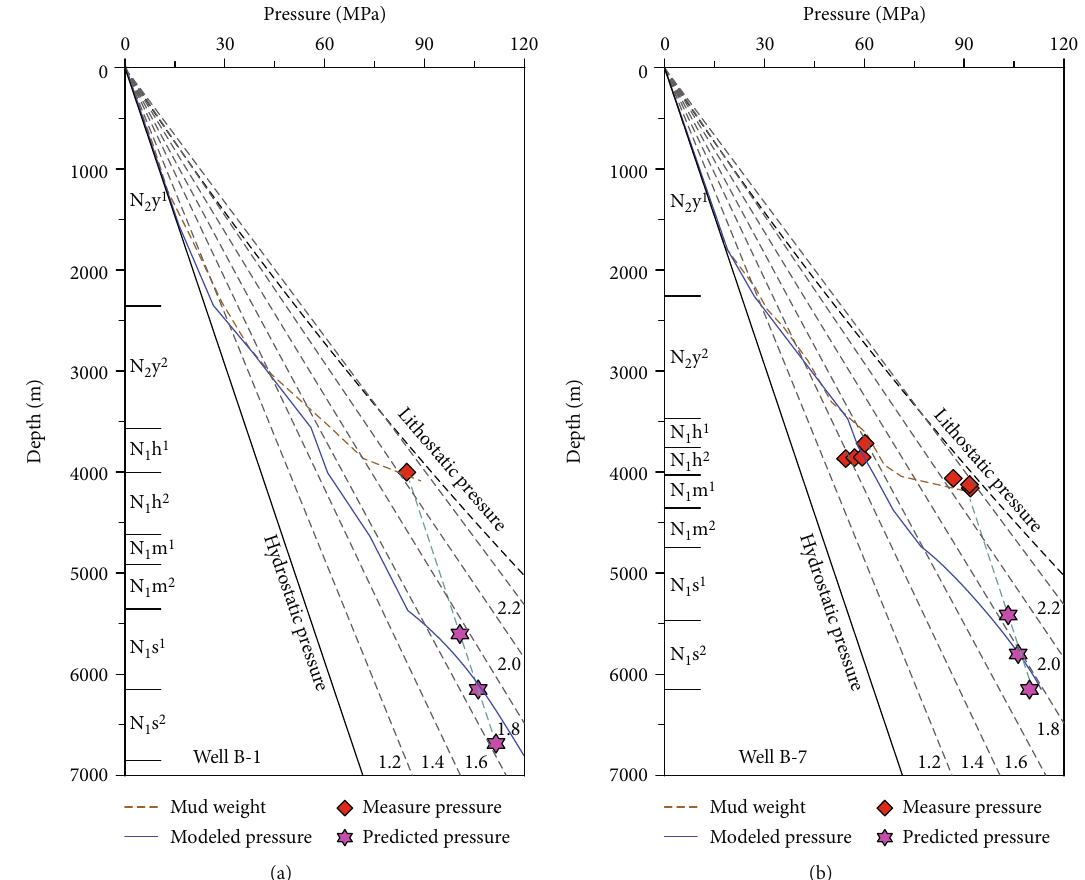
Figure 10: The modeled pressure of the ultradeep buried source rock in the LD-B Wellblock. The stars are the predicted pressure according to the characteristics of the vertical transfer pressure, which is parallel to the hydrostatic pressure. The location of the well is shown in Figure